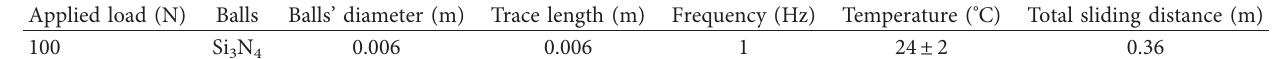
Table 2: Wear test parameters.